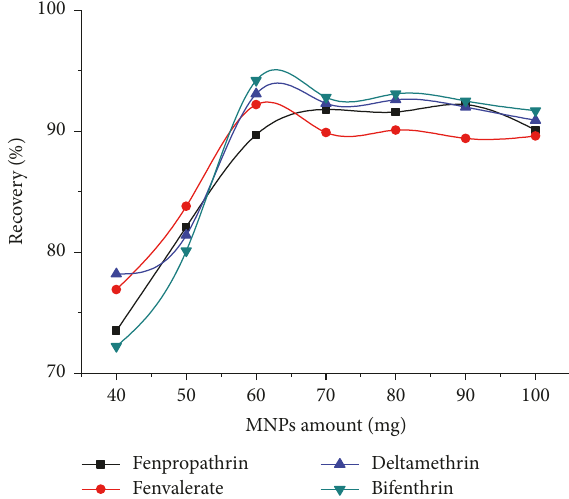
Figure 5: Effect of the amount of MNPs. Extraction condi- tions: sample volume, 50.0 mL spiked with 100 ng mL −1 of four pyrethroids; pH, 7.0; ultrasonication time, 2 min; eluent solvent, 2 mL of acetonitrile/acetic acid (9:1, v/v).